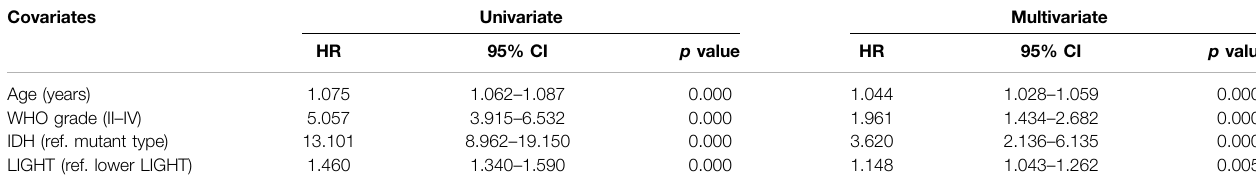
TABLE 2 | Cox logistic regression analysis of overall survival in the TCGA cohort.